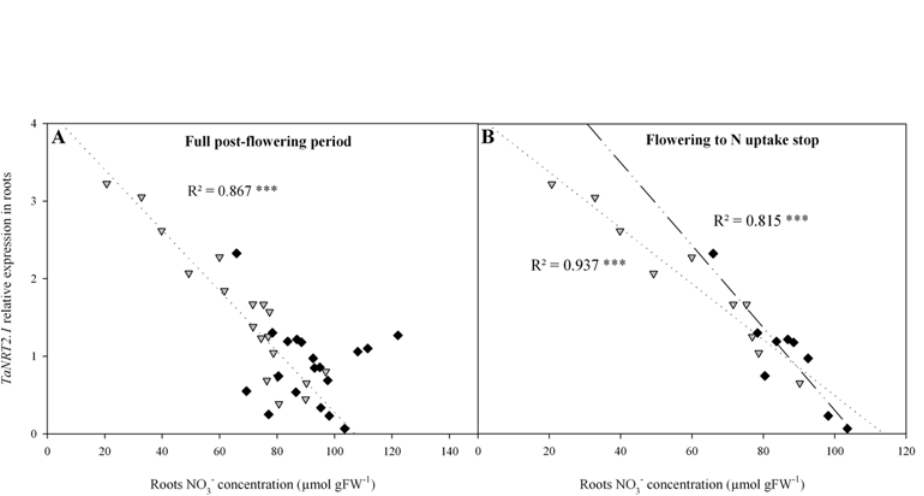
Fig 6. Relations between roots NO 3- concentration and relative expression level of TaNRT2 . 1 in roots for two contrasting NO 3- treatments (N4 and N10) from flowering (GS65) to GS65+800DD (A) and from flowering (GS65) until NO 3- uptake stop (respectively GS65+400DD and GS65+300DD for N4 and N10) (B). Values are the three individual biological repetitions for seven post-flowering sampling dates for N4 (grey triangles) and N10 (black diamonds) (A) or respectively four and three sampling dates for N4 and N10 (B). Gene expression quantification was performed by qRT-PCR. Relative expression values were calculated using the Δ CT method corrected for primer efficiency, using Ta54280 and Ta54948 as internal controls. Statistical analyses were by the Pearson correlation